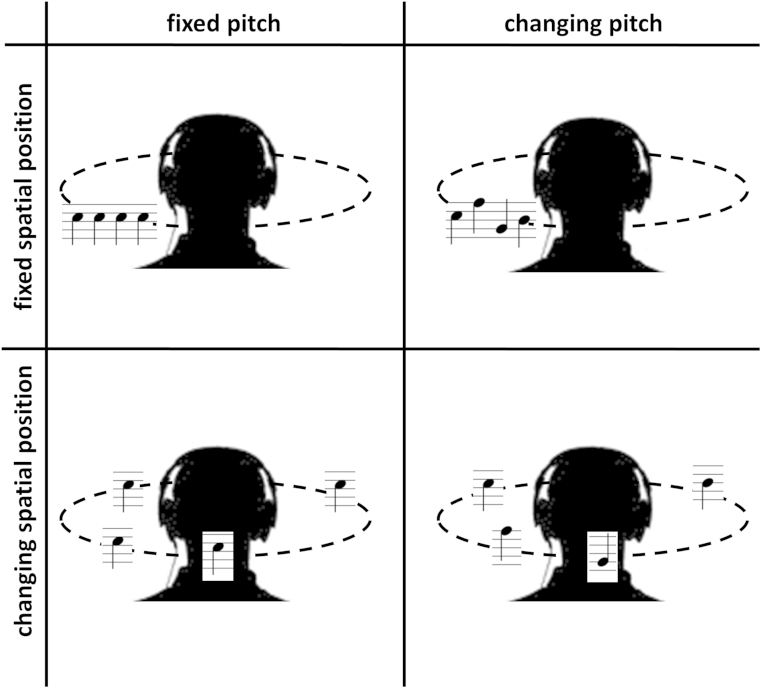
Examples of stimulus condition trials in the fMRI experiment are represented schematically (conditions were presented in randomized order during scanning). Dotted lines represent the azimuthal plane. The spatial steps and musical notation shown here are purely for illustrative purposes; stimuli were based on smaller spatial steps and pitch values that do not correspond to intervals in traditional Western music.